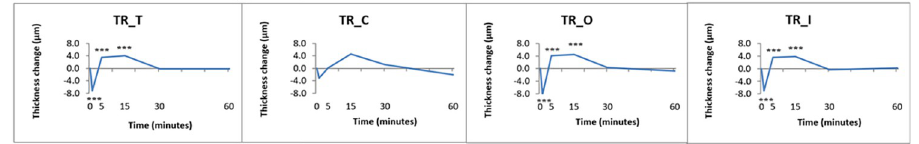
Fig 4. Changes of total retinal thickness over time following vita maxima strain of the study participants. Data are shown in the total macular area (T), the central subfield (C), the inner (I) and outer ring (O). � : p < 0.05 (missed significance), �� : p < 0.01 (missed significance), ��� : p < 0.001 (significant). For mean and SD values see S4 Table. (For the abbreviations of the layers see Fig